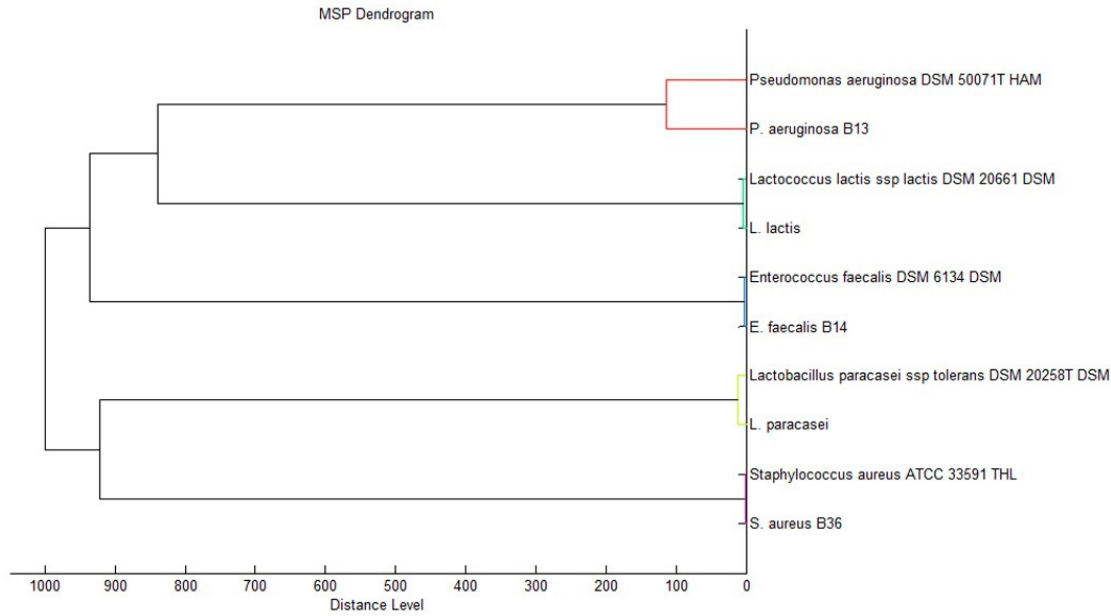
Figure 10. Phyloproteomic tree of the isolated bacterial strains, identified by MALDI Biotyper Compass platform.